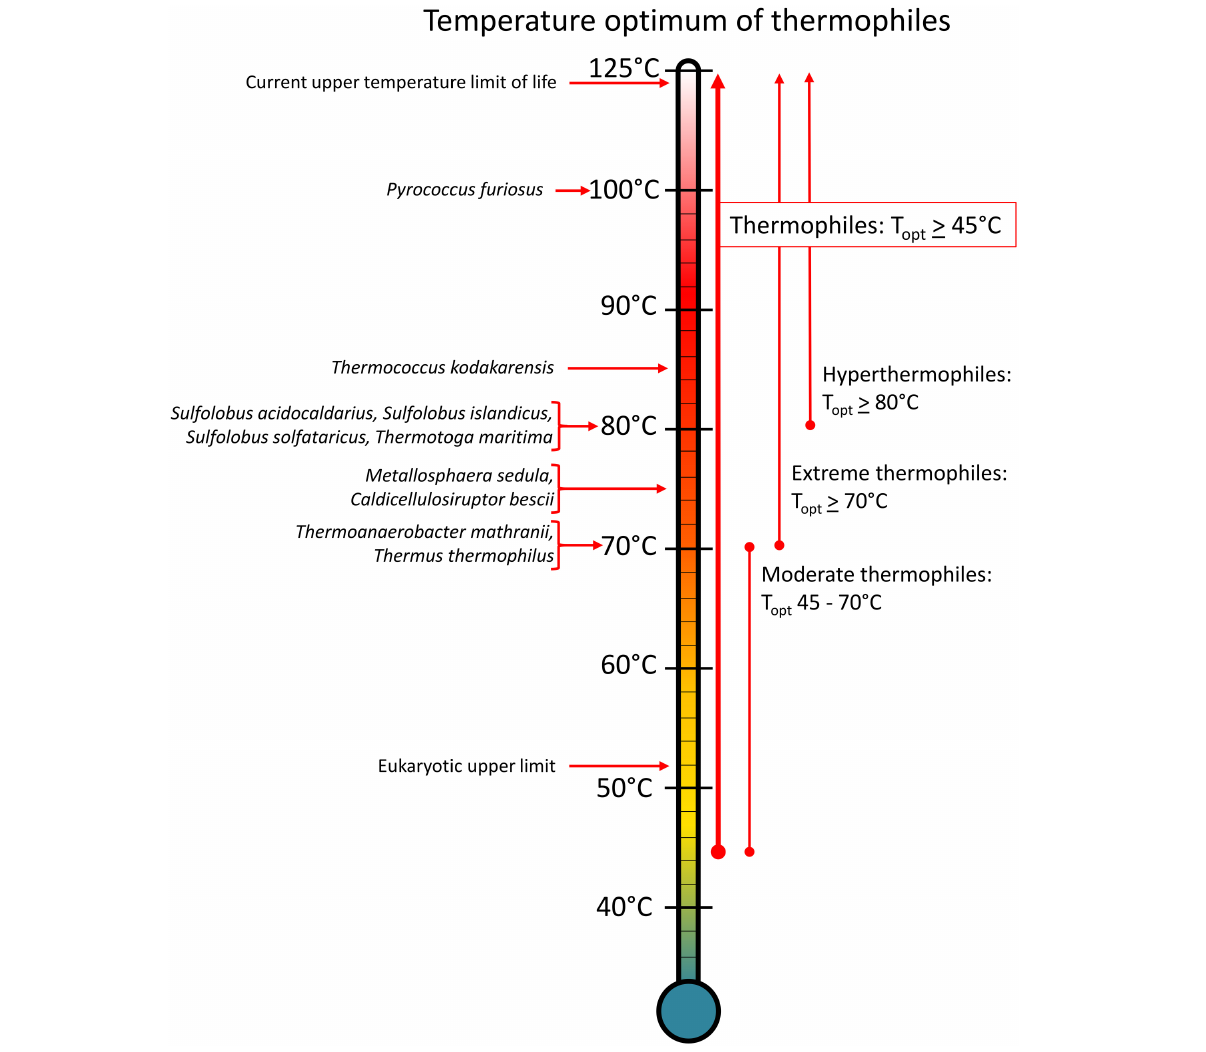
FIGURE 1 | Genetically tractable extreme thermophiles and their optimum growth temperatures. Any organism with an optimum temperature above 45 ◦ C is classified as a thermophile, but this range is extremely broad and extends 80 ◦ units up to the upper limit of life. Therefore, thermophiles have been further subdivided into moderate thermophiles that grow optimally between 45 and 70 ◦ C, extreme thermophiles that grow optimally at 70 ◦ C and above, and hyperthermophiles that grow optimally at 80 ◦ C and